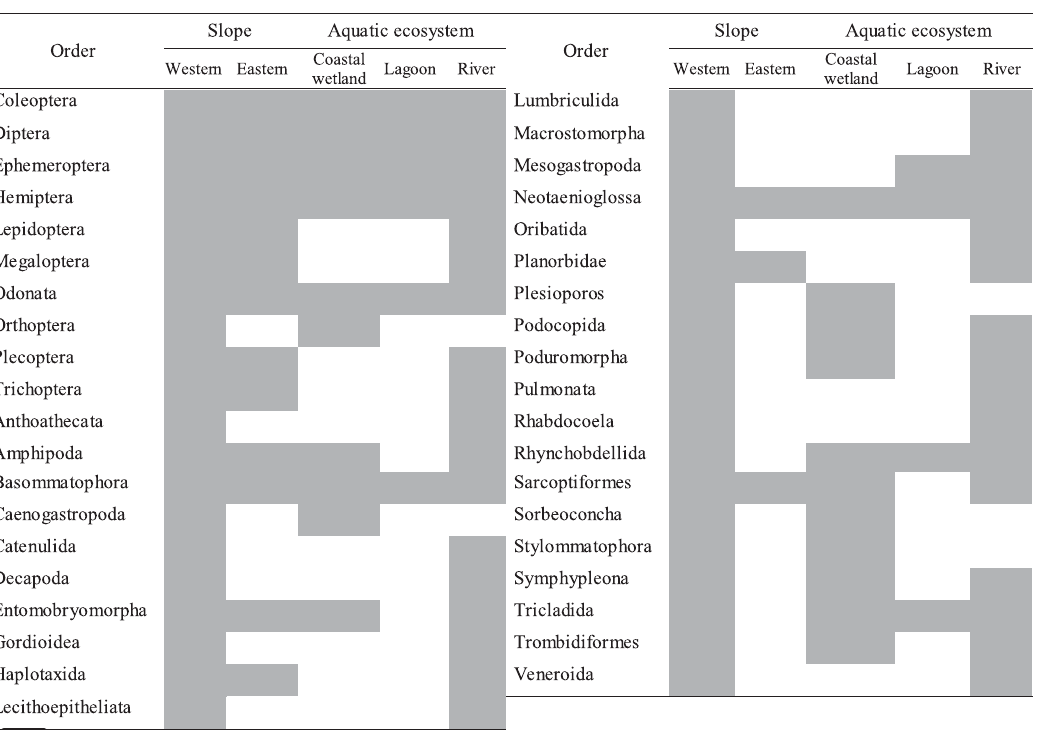
TABLE 5 | Orders of macroinvertebrates by hydrographic slope and aquatic ecosystem, according to research studies carried out between years 1992 – 2020.